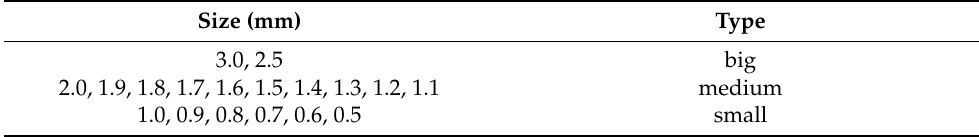
Table 7. Classification label of wear particles used in the experiment.